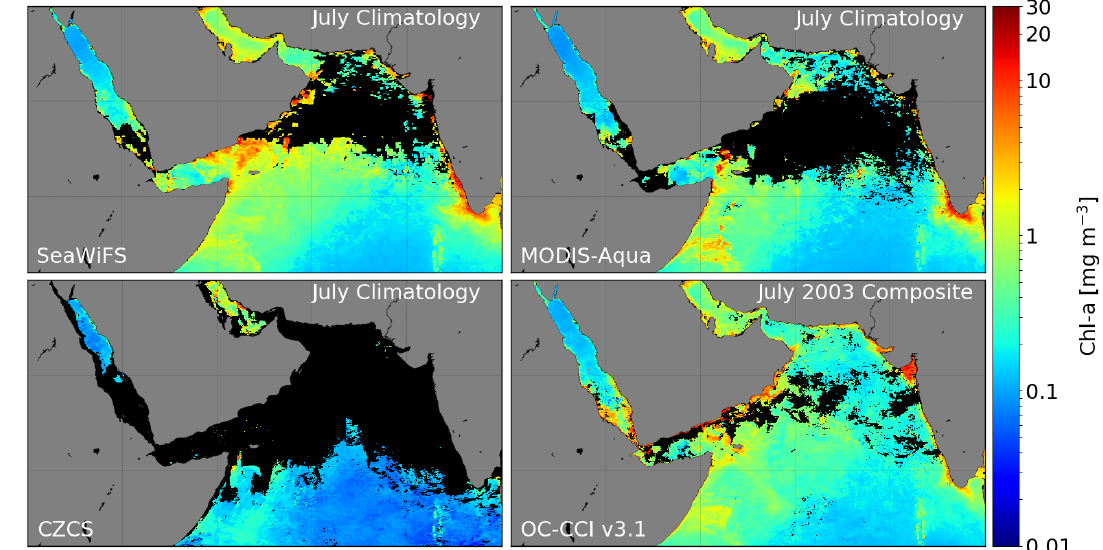
Figure 8. Monthly coverage of ocean-colour-derived chlorophyll data for the Arabian Sea. Black represents missing data. Top left panel: SeaWiFS July Climatology from NASA; top right panel: MODIS-Aqua July Climatology from NASA; bottom left panel: CZCS July Climatology from NASA; and bottom right panel: OC-CCI-v1.0 July monthly composite for one sample year